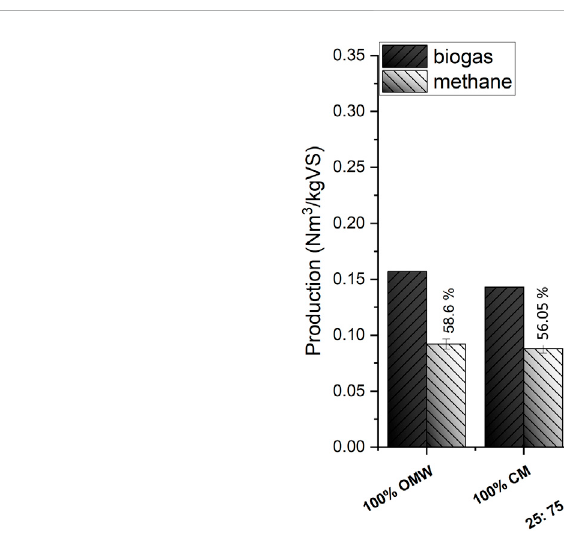
FIGURE 3 Speci fi c biogas and methane production of all tests of all BMP